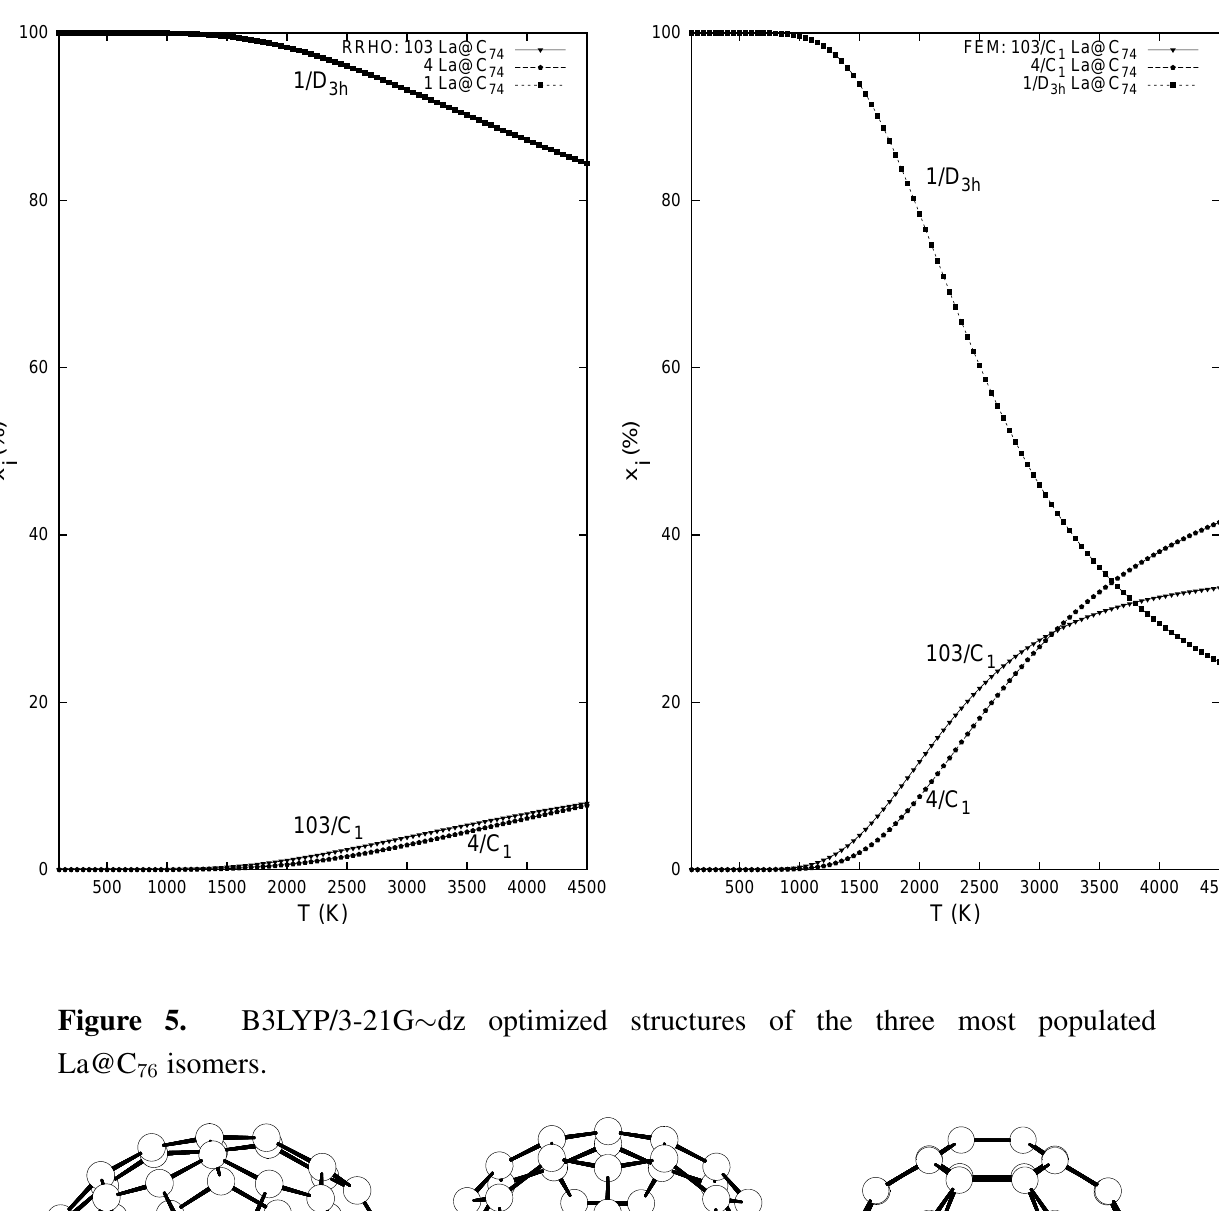
Figure 4. Relative concentrations of the La@C B3LYP/6–311G (cid:3) (cid:24) sdd energetics, B3LYP/3-21G (cid:24) dz entropy, and RRHO (left) or FEM (right) treatment.